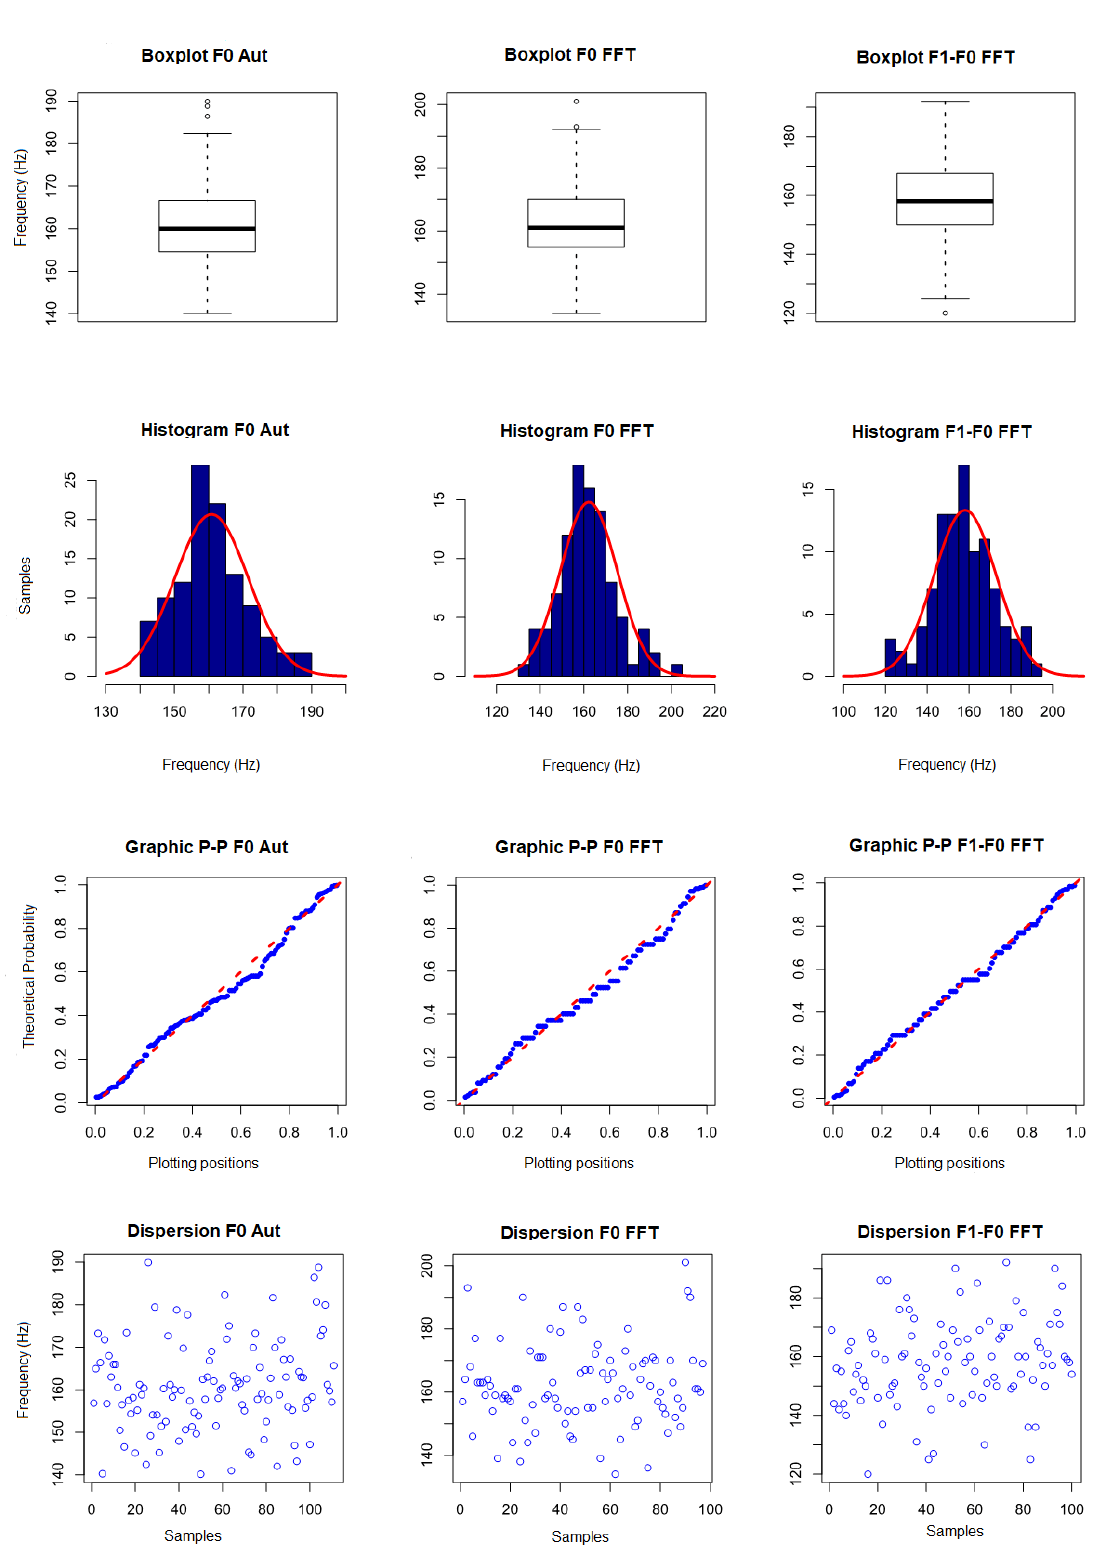
Figure 25. Graphics of the visual evaluation of the data obtained with the events of passage of C. capitata of the standard group without